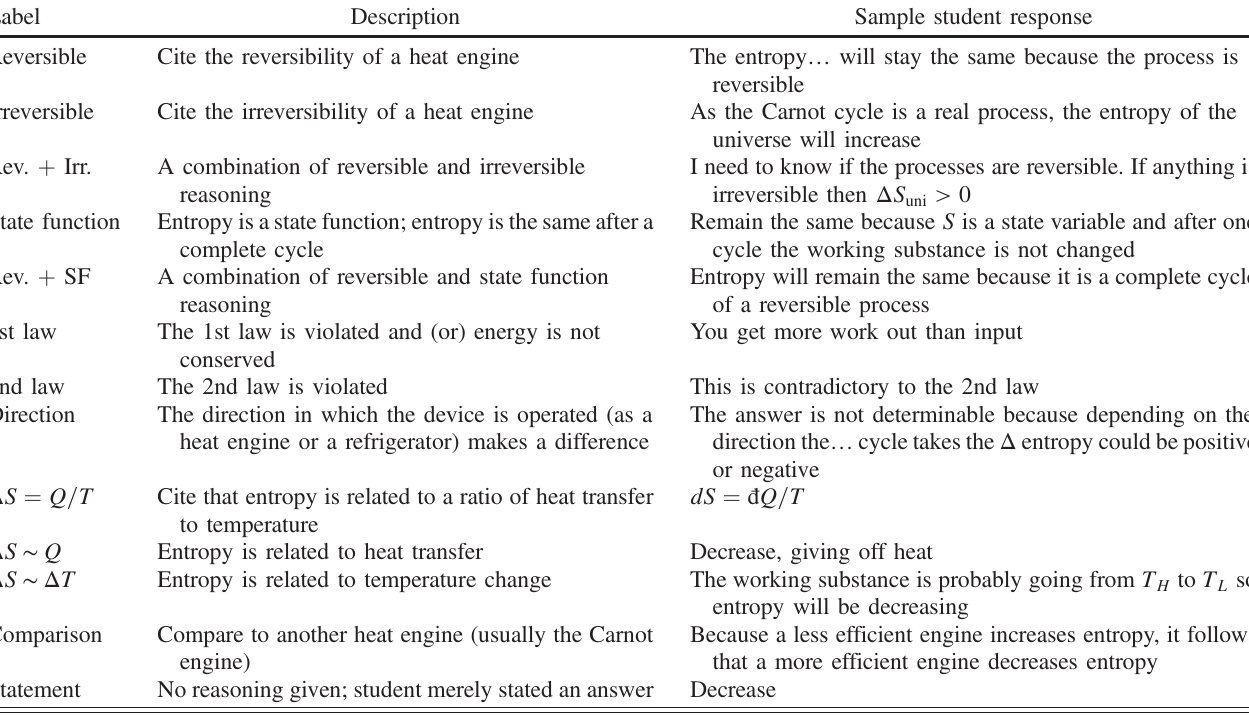
TABLE I. Reasoning on the EEQ pretest. Categories determined by an open analysis of students ’ written responses to the EEQ pretest.